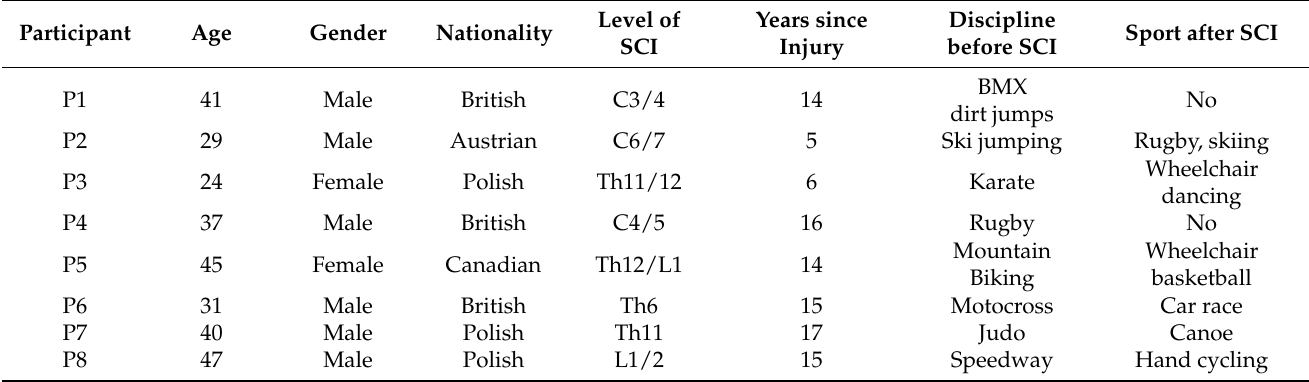
Table 1. Sociodemographic data of study participants. C-cervical spine, Th–thoracic spine, L– lumbal